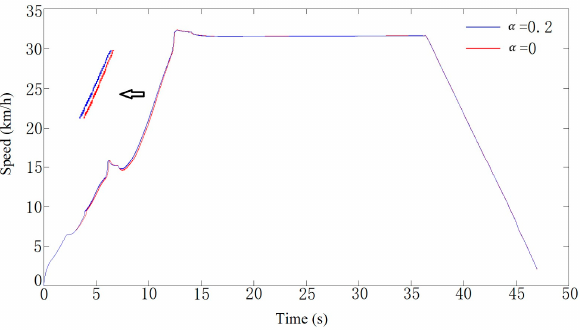
Figure 21. Comparison of actual speed of 𝛂 = 𝟎 and 𝛂 = 𝟎.𝟐 under working condition A.